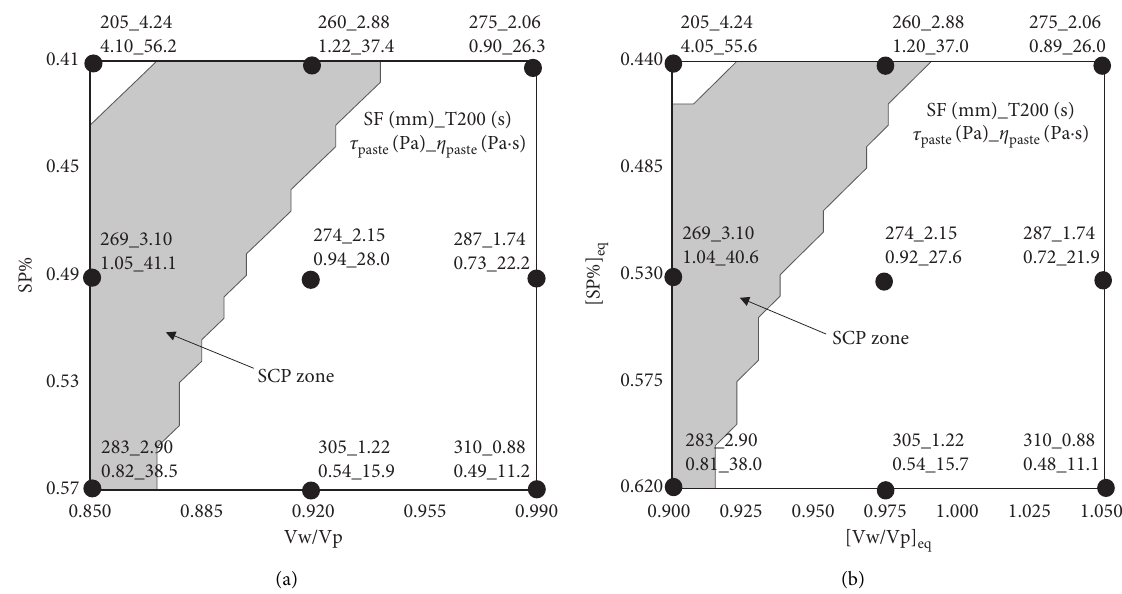
Figure 9: Results of the mini-SF tests on pastes with cement and LP as powder (a) before equivalence; (b) after